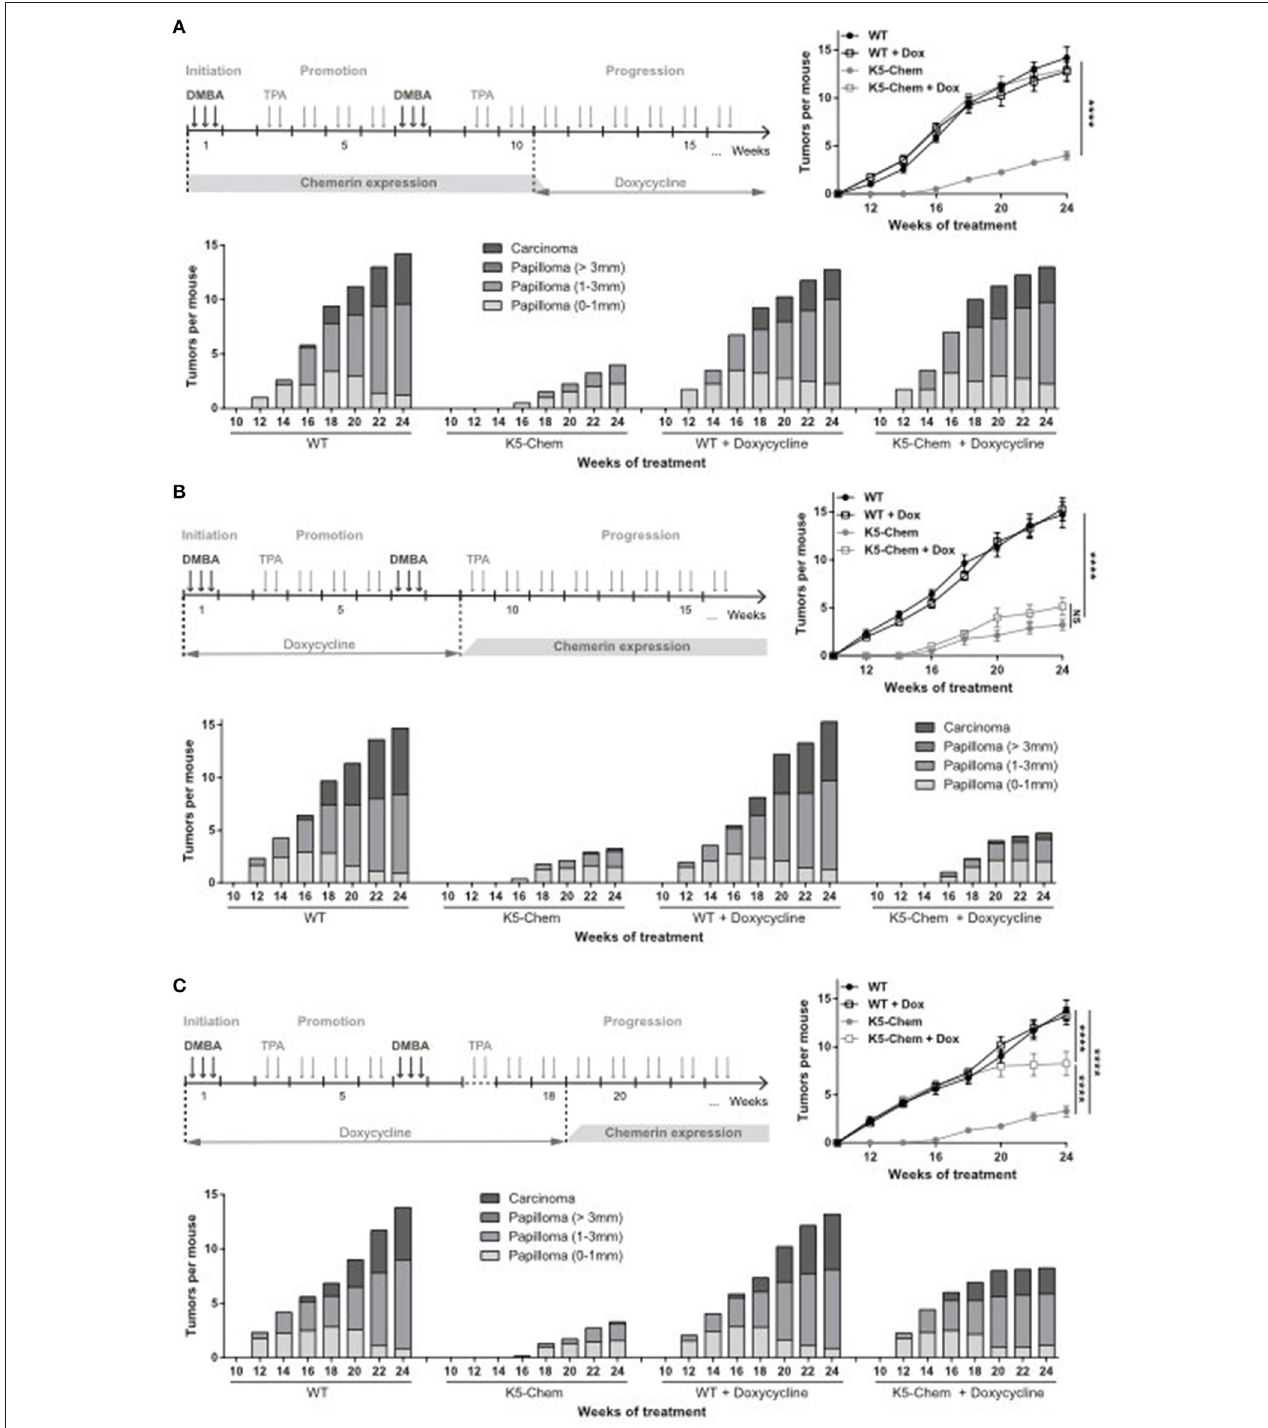
FIGURE 7 | Chemerin expression affects only the late stages of tumor progression. WT and K5-chemerin mice were subjected to the DMBA/TPA chemical carcinogenesis model. They were treated or not during part of the protocol with doxycycline, in order to inhibit expression of the chemerin/eGFP transgene in K5-chemerin mice. Three schemes of doxycycline treatment were used: (A) From week 11 up to the end of the protocol, (B) from a week before initiation of the protocol to the end of week 8, or (C) for a week before initiation of the protocol to the end of week 18. For each treatment scheme, the number of tumors per mouse (right graph, mean ± SEM) and the proportion of tumors according to size and stage (histogram) were recorded every other week. The displayed data result from the compilation of three (A) or two (B,C) independent experiments with n ≥ 6 mice per group in each experiment. The data are analyzed by two-way ANOVA. **** P <